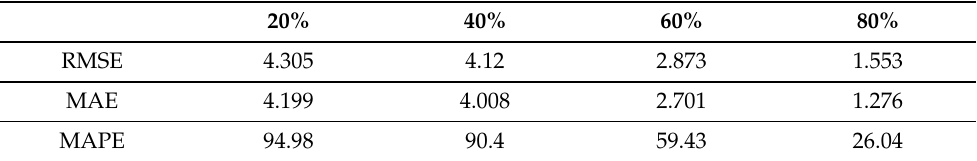
Table 8. DCNN model weight experimental result table.